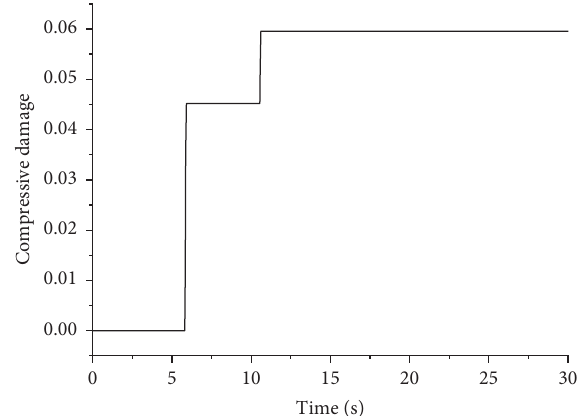
Figure 17: The compression damage at the integration point of the dam heel for the overload coefficient of